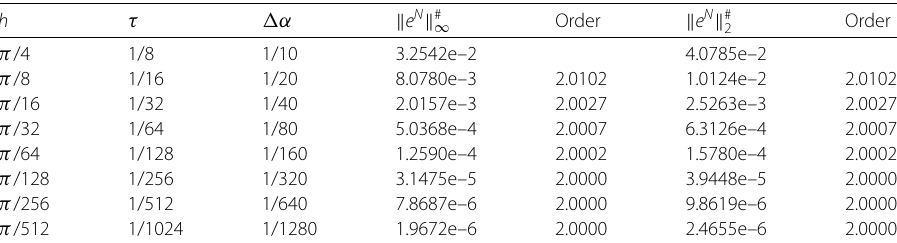
Table 4 The discrete L 2 errors, maximum errors, and their convergence rates for scheme (8) for Example 2 when v 1 = 0.1 and v 2 = 0.9